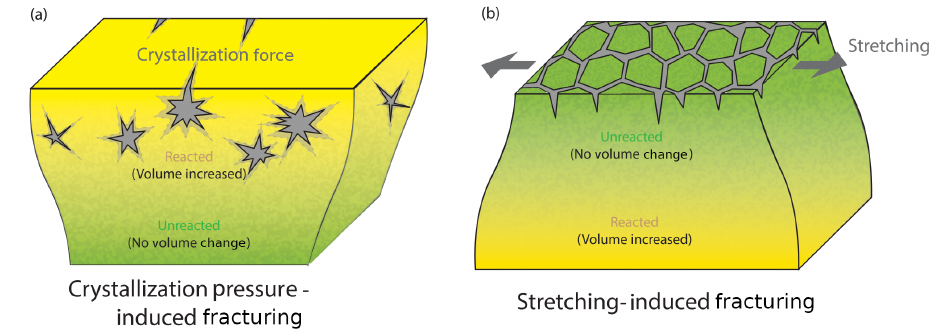
Figure 1. Illustration of the mechanisms of reaction-induced fracturing during olivine–fluid interaction. (a) The crystallization pressurization model describes the development of fractures caused by crystallization forces exerted on the surroundings due to growth of precipitates. Salt crystallization (Scherer, 2004) is a typical example of the crystallization pressure-induced fracturing. The fractures first appear at areas where precipitation is most concentrated and propagate outwards. (b) The surface cracking model describes the development of fractures as a result of a contrast in expansion which causes stretching at the surface. A difference in the precipitation rate between the periphery and interior of the sample causes them to expand at different rates with the interior expanding faster than the surface. This builds up the tensile stress at the surface that fractures the sample and leads to a development of a polygonal fracture network. The fractures propagate from the surface